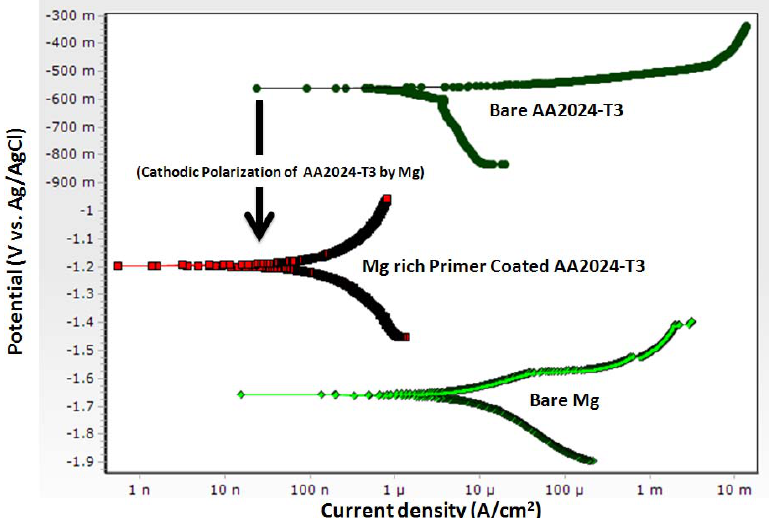
Figure 5. DC potentiodynamic polarization measurement of Mg-rich primer coated AA2024T3, bare AA2024 T3 and bare Mg in 3.5 wt% NaCl solution. (scan rate of 0.166 mV/s, polarization range: OCP − 0.25 mV and OCP +0.25